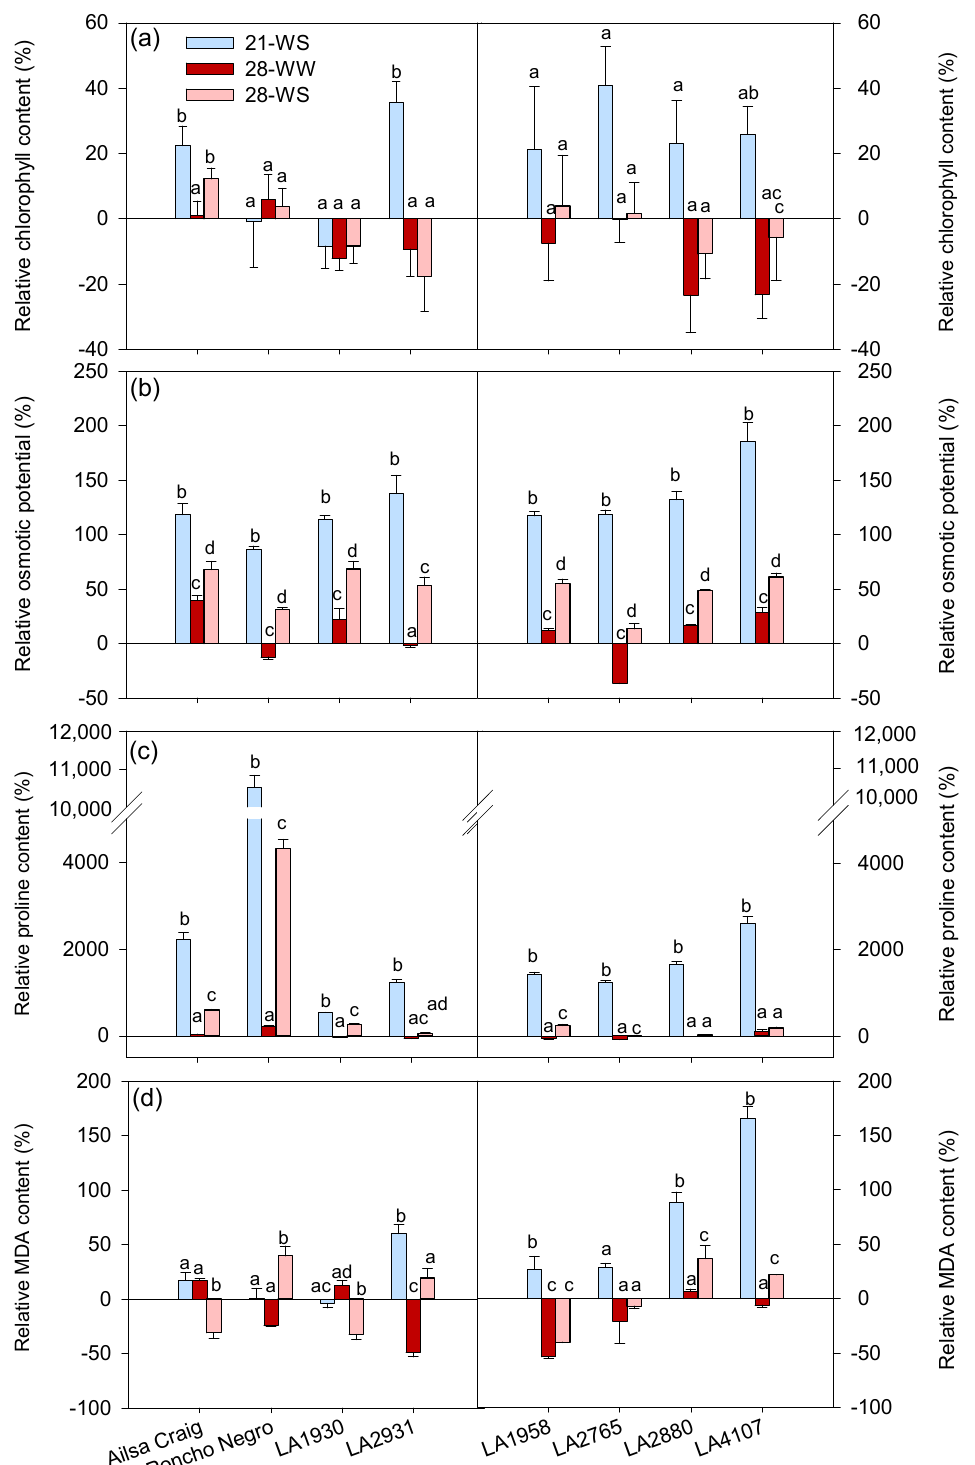
Figure 6. Effect of temperature and water stress on leaf ( a ) chlorophyll concentration, ( b ) osmotic pressure, ( c ) proline concentration, and ( d ) malondiadehyde concentration of S. lycopersicum cultivars and S. chilense populations: relative values to the control condition (21-WW) for each accession. Plants were grown at 21 ◦ C under well-watered (21-WW) and water-stressed (21-WS) conditions or at 28 ◦ C under well-watered (28-WW) and water-stressed (28-WS) conditions. Treatments followed by different letters are significantly different at p < 0.05 for the same accession (considering that the control plants are a). Data ± SE.